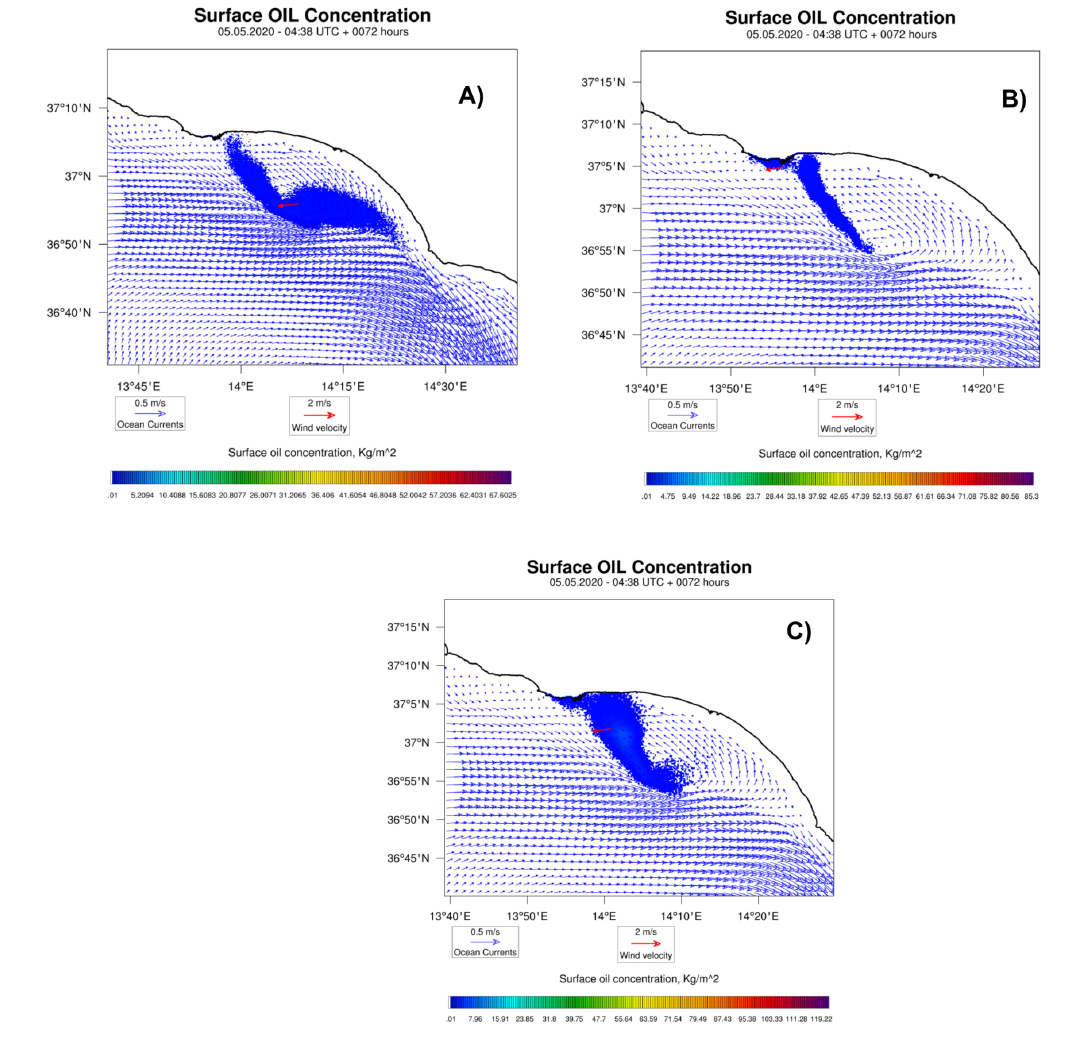
Figure 6. Forecast at 72 h of the oil concentration at the experiments with a massive oil spill (panel ( A )), a wind drift term correction (panel ( B )), and a continuous oil spill (panel ( C